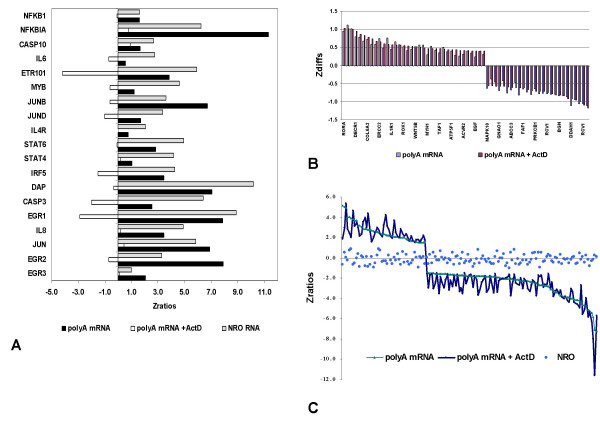
Persistence of stability-regulated changes in gene expression in the presence of Actinomycin D. A. Effect of Actinomycin D on the (P+I)-induced changes in the expression patterns of gene deemed to be transcriptionally regulated. Z ratio comparisons are made to the baseline or unactivated state. B. Lack of an effect of Actinomycin D on the (P+I)-induced changes in the expression patterns of genes deemed to be stability regulated. The absolute differences (Z diff) between the activated and un-activated state for both polyA mRNA and NRO RNA for a subset of these genes is shown. C. Comparison of the Z ratios for all significantly regulated genes in the presence or absence of Actinomycin D showing no corresponding regulation in NRO RNA. Data is sorted by polyA mRNA (without ActD) values and a significance threshold of Z ratios > ± 1.5 was used for these calculations.